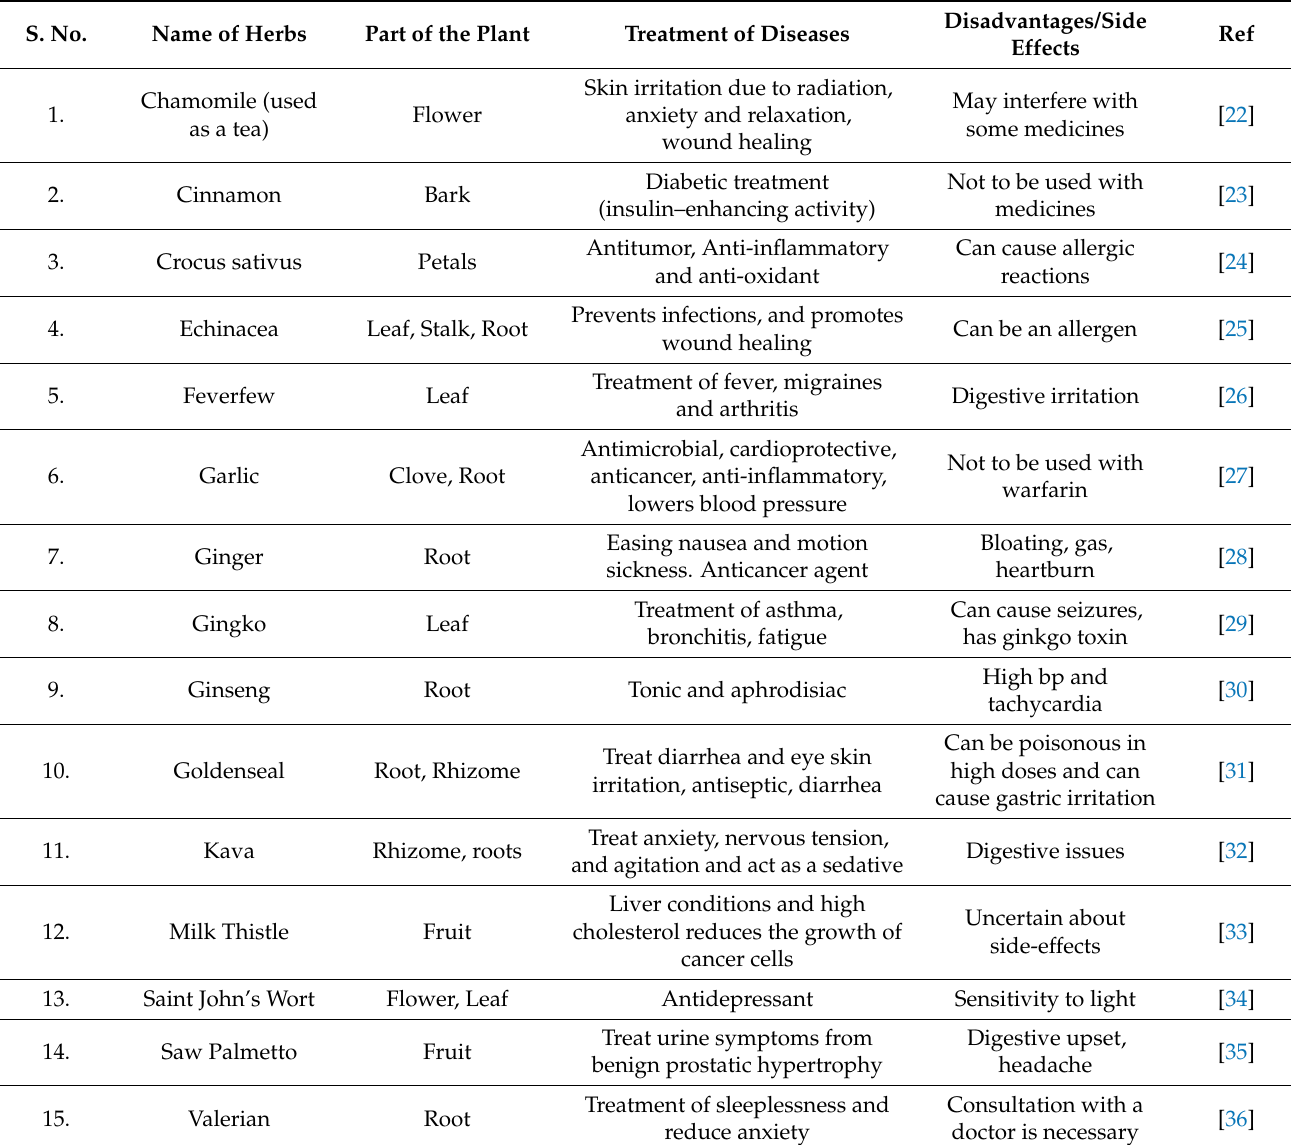
Table 1. Accounts the name of various phytochemical defense compounds/foods used in our daily routines with tremendous benefits and few side